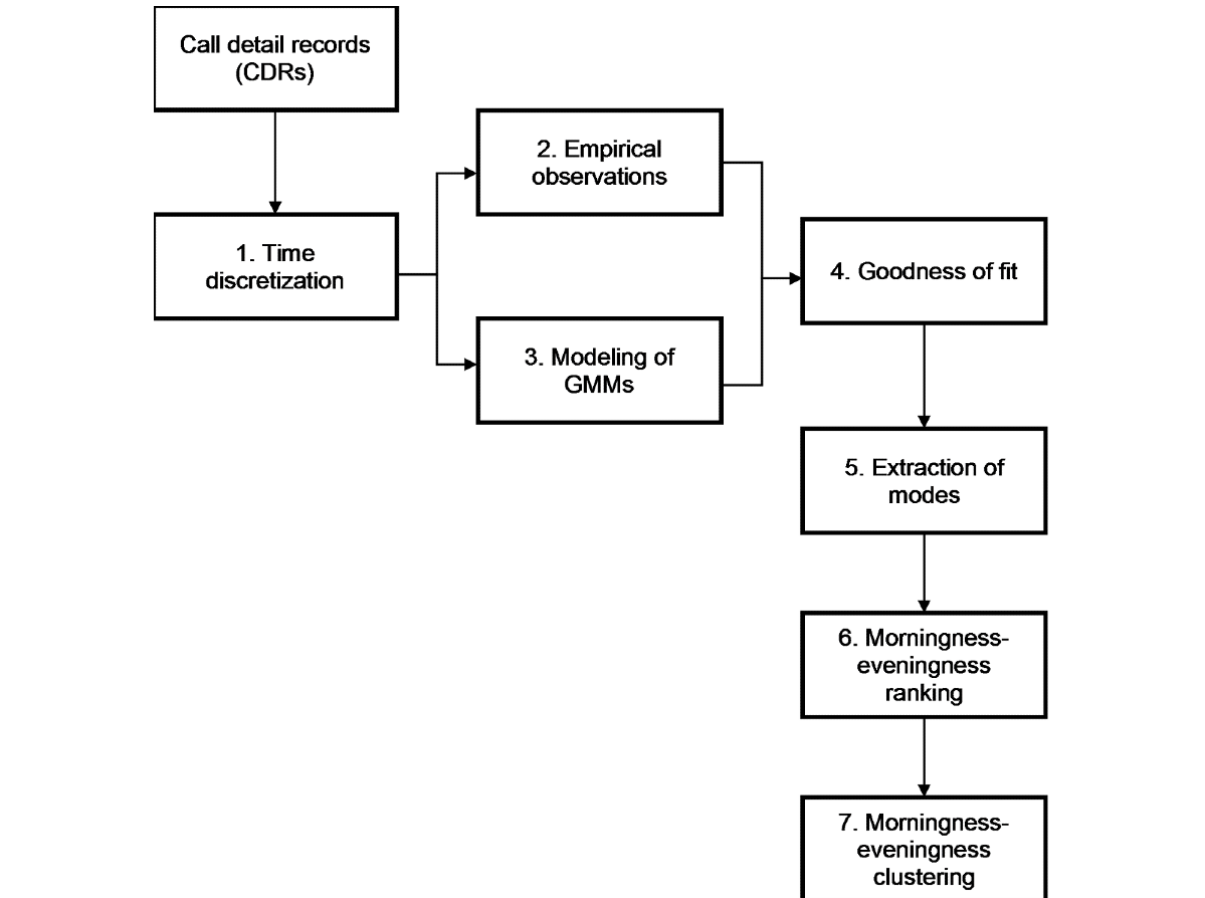
Figure 1. Data analysis pipeline. Step 1 corresponds to data preprocessing, Steps 2-4 correspond to circadian rhythm modeling, and Steps 5-7 correspond to social morningness-eveningness clustering. GMM: Gaussian mixture